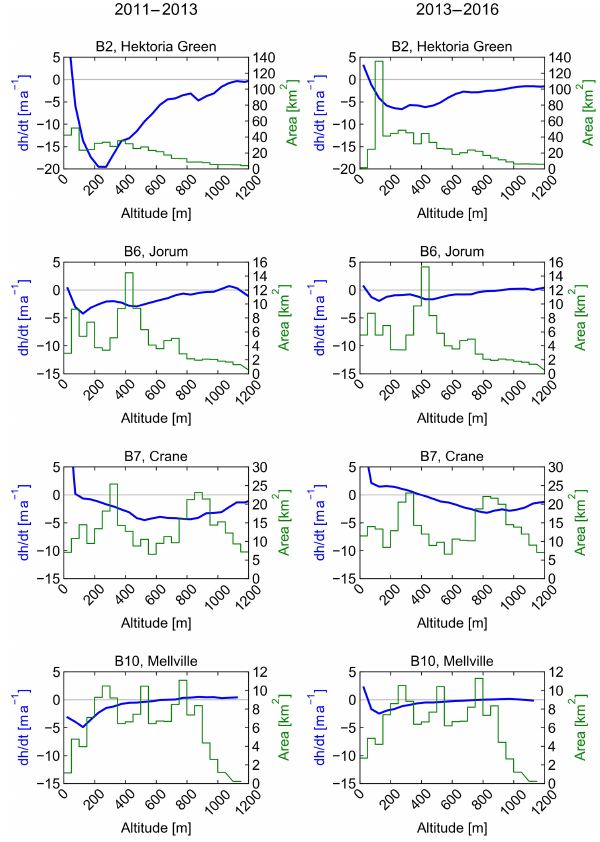
Figure 8. Rate of glacier surface elevation change d h/ d t (in ma − 1 ) from 2011 to 2013 and from 2013 to 2016 versus altitude in 50m intervals for basins B2, B6, B7 and B10. Green line: hypsometry of surveyed glacier area in km 2